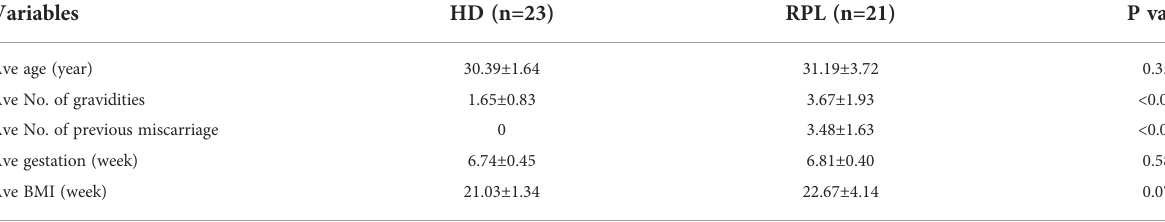
TABLE 1 Clinical characteristics of HDs and RPL